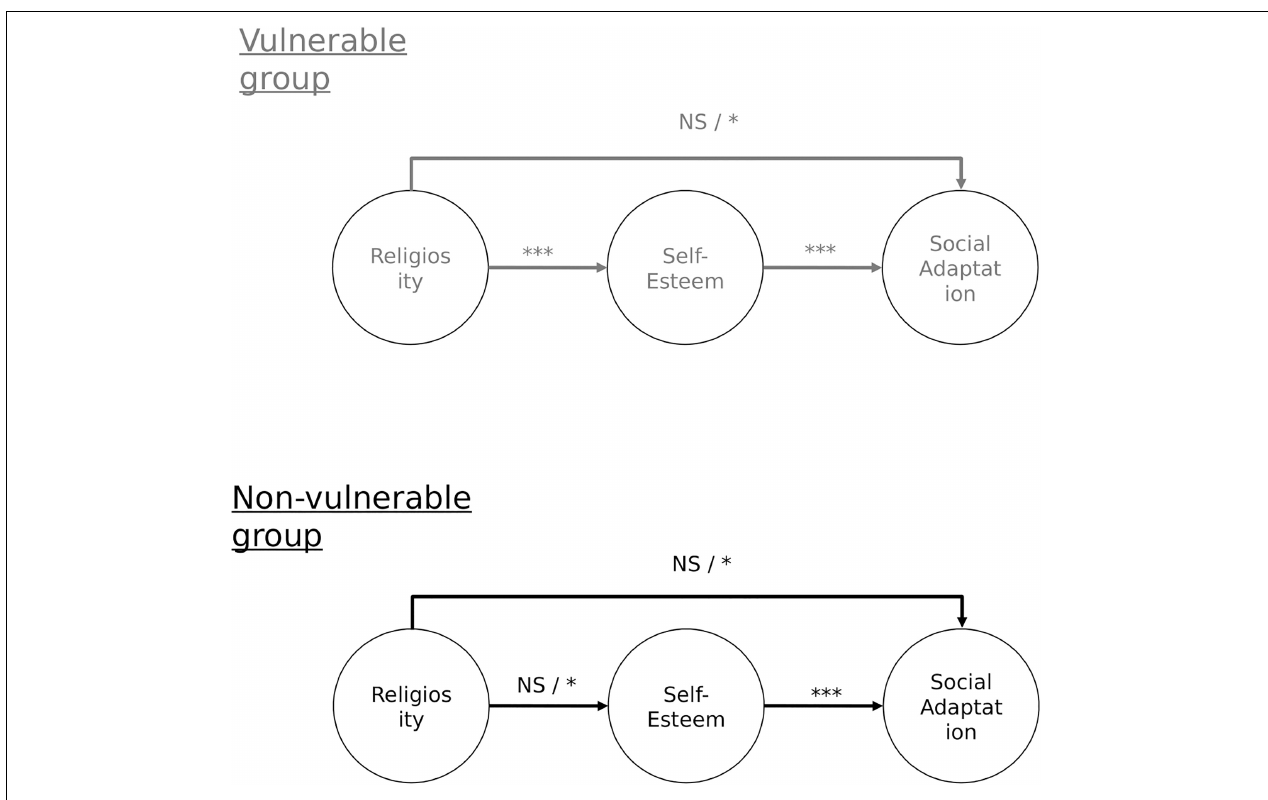
FIGURE 1 | Data for the model in gray were collected before pre-registration. * p < 0.05; ** p < 0.01; *** p < 0.001, NS, non-significant.